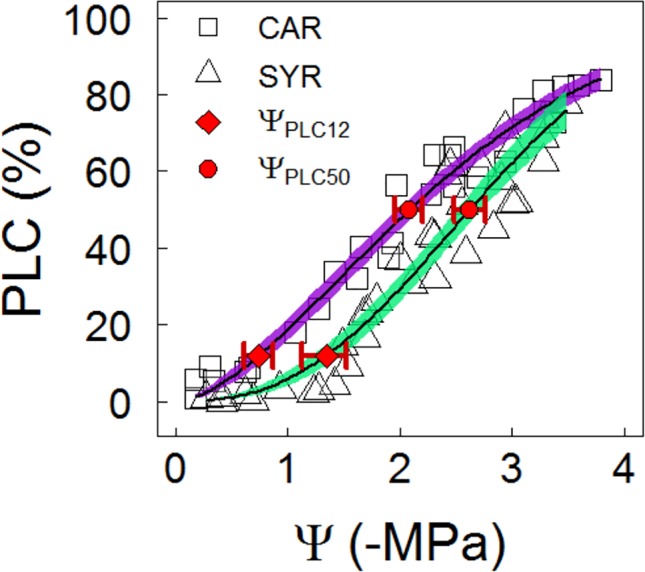
Shoots vulnerability curves of grapevines under a slow drying over a bench. Purple squares and green triangles represent the relationship between PLC and Ψ in Carménère and Syrah, respectively, from the Maipo Valley. For each curve, the predicted mean (black solid line) and the 95 % CI (colored areas) are shown. A difference in ΨPLC12 (red diamond) and ΨPLC50 (red circle) between varieties was deemed to be significant due to the lack of overlap between CIs (red bars).